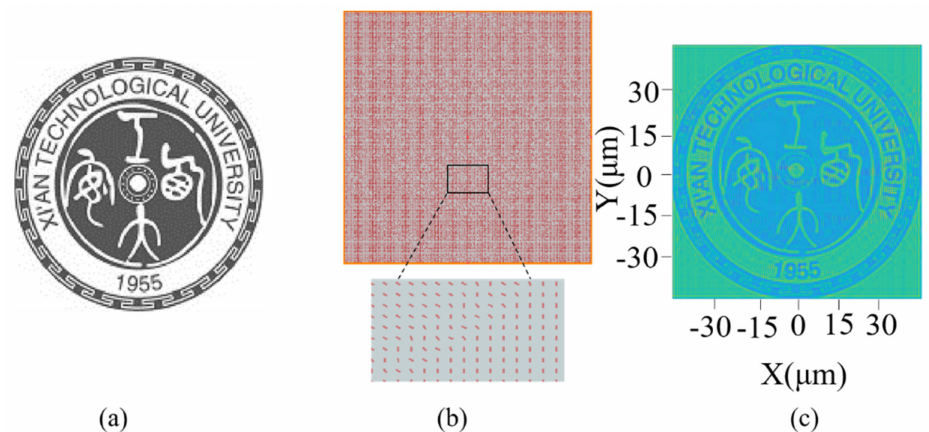
Figure 7. ( a ) The target image. ( b ) The arrangement of the nano‑Polarizer array. ( c ) The near‑field light intensity distribution of the output